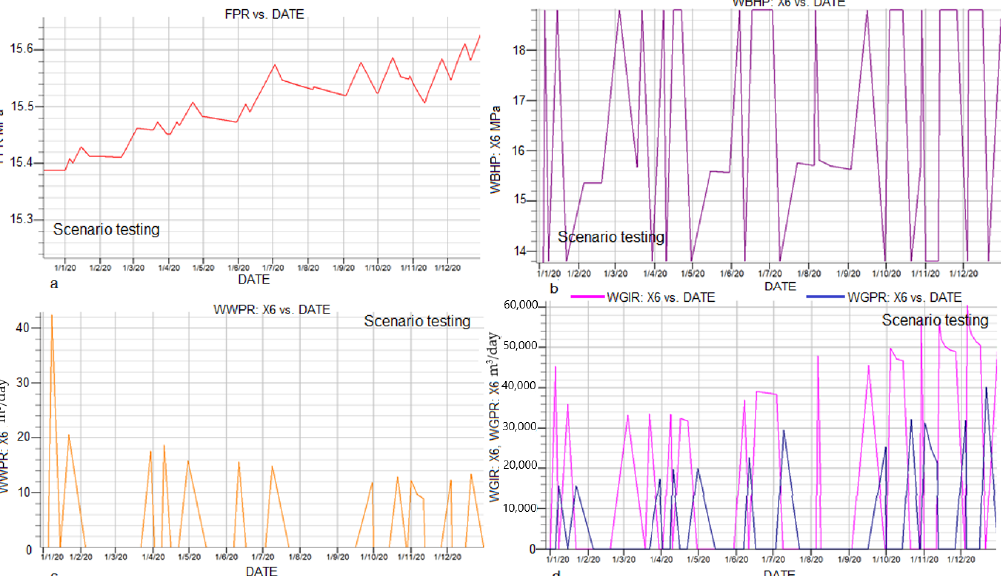
Figure 11. The fluctuation of electricity produced in German from renewable sources in 2017 is modelled into a future scenario testing case without limited water cut-off. The excess of energy can be stored in UGS reservoirs and can be used when needed. This schedule is helpful to understand which month of the year’s energy can be stored as gas in UGS and in which month of the year this energy can be utilized when shortages occur: ( a ) field pressure (FPR) profile for these cycles; ( b ) well bottom hole pressure (WBHP) of well X6; ( c ) well water production rate (WWPR) for well X6; and ( d ) injection (WGIR) and production (WGPR) gas rates for well X6.